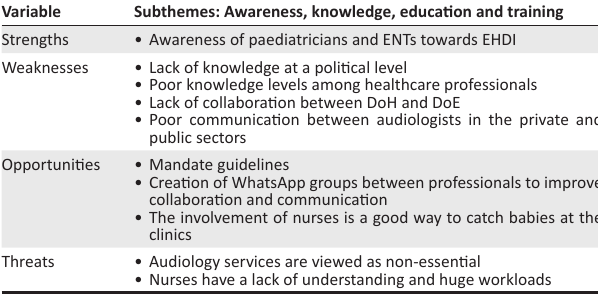
TABLE 3: Strengths, weaknesses, opportunities, and threats for theme 3: Facilitating and strengthening intersectoral collaboration.